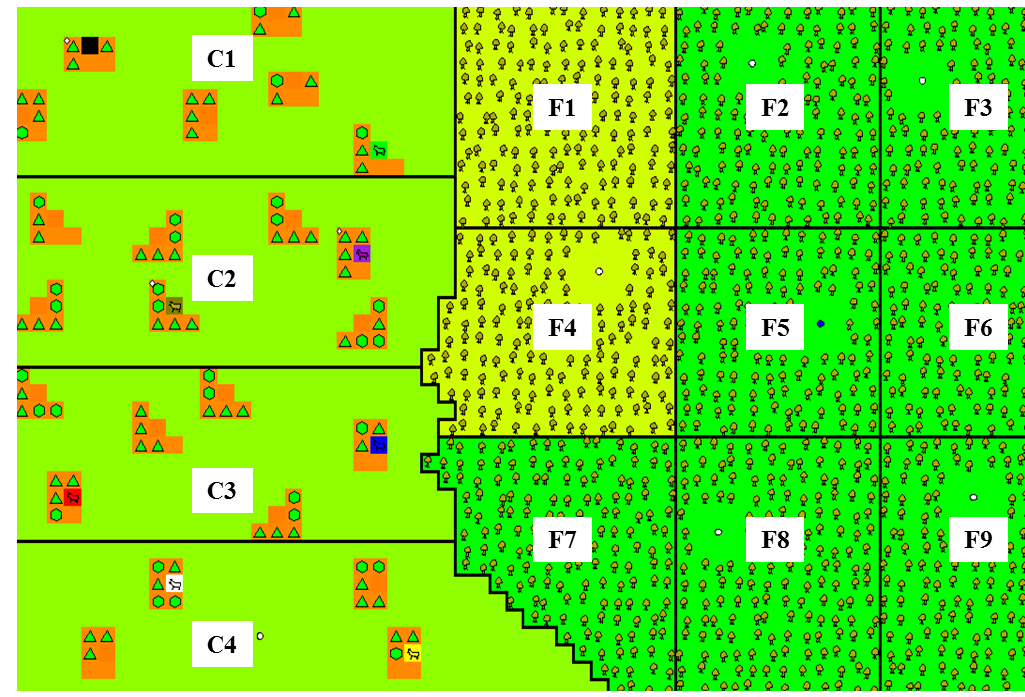
Figure 2. The virtual environment. The virtual environment is divided in 13 GrazingAreas numbered C1 to C4 in the communal land, F1 to F9 in the forest. Each played Farm has its Kraal colored according to the player in charge (2 played Farms by communal GrazingArea), the 5 fields appearing in orange (5 orange cells around the Kraal). Farms with no Kraal are clones managed by the model. The green entities seen on fields represent growing Crops (triangles are short term maize; rounds are long term maize). The figure shows three of the four different forage levels: “poor” (F1 and F4); “medium” (C1 to C4). and “good” (F2, F3, F5, F6, F7, F8 and F9). These levels change during the game according to players’